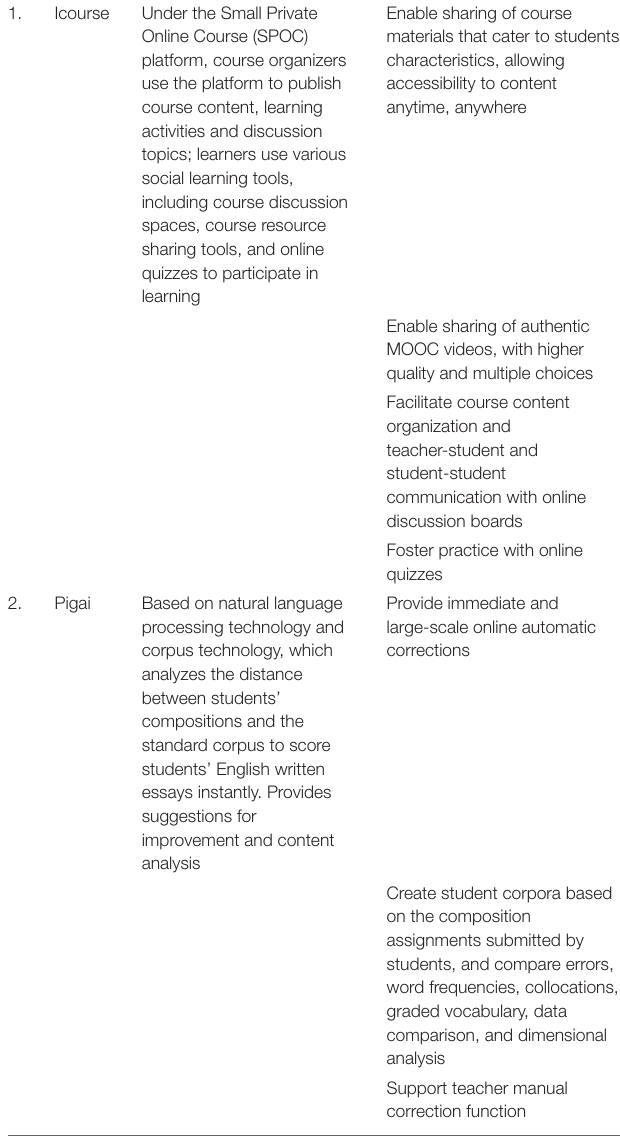
TABLE 1 | Definition of Icourse and